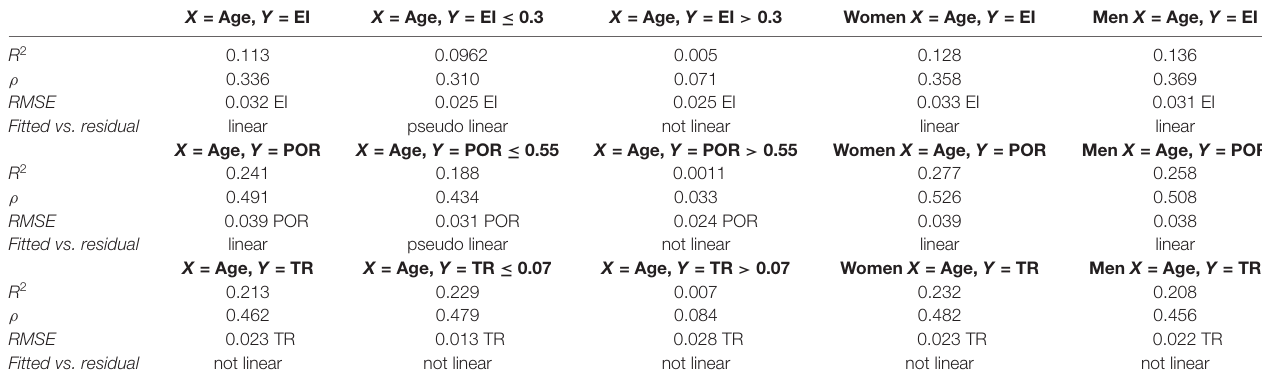
TABLE 3 | Summary of regression analysis.